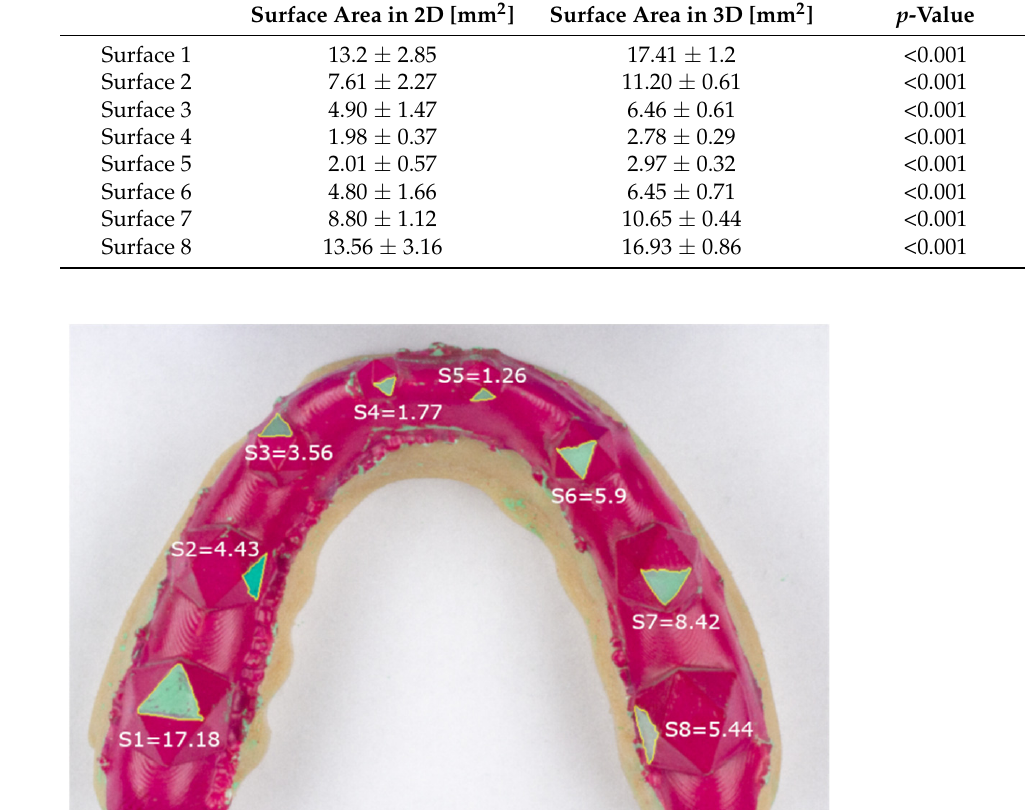
splints measured from 2D photographs and 3D scans. p -values are reported for independent-sam- ples t -test for differences between the measurement methods.